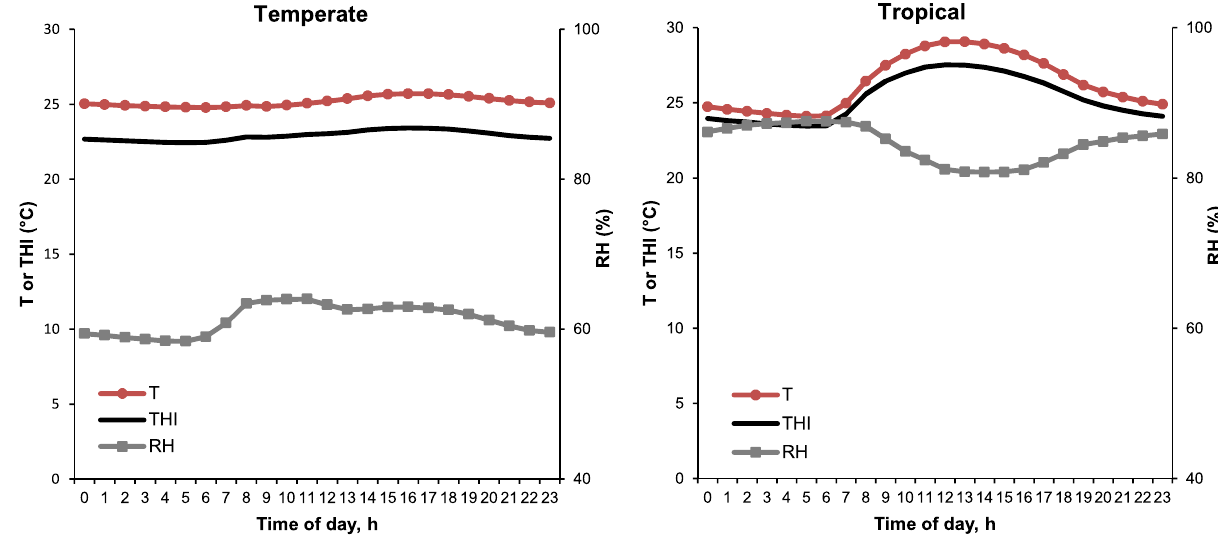
Figure 1. Hourly climatic variation in the pig building accrording to the production environment (temperate or tropical). T = ambient temperature, RH = relative humidity, THI = temperature-humidity index, calculated according to the following formula: THI (°C) = T − (0.55 − 0.0055 × RH) × (T − 14.5), proposed by the National Oceanic and Atmospheric Administration 49 , cited by Zumbach et al . 50